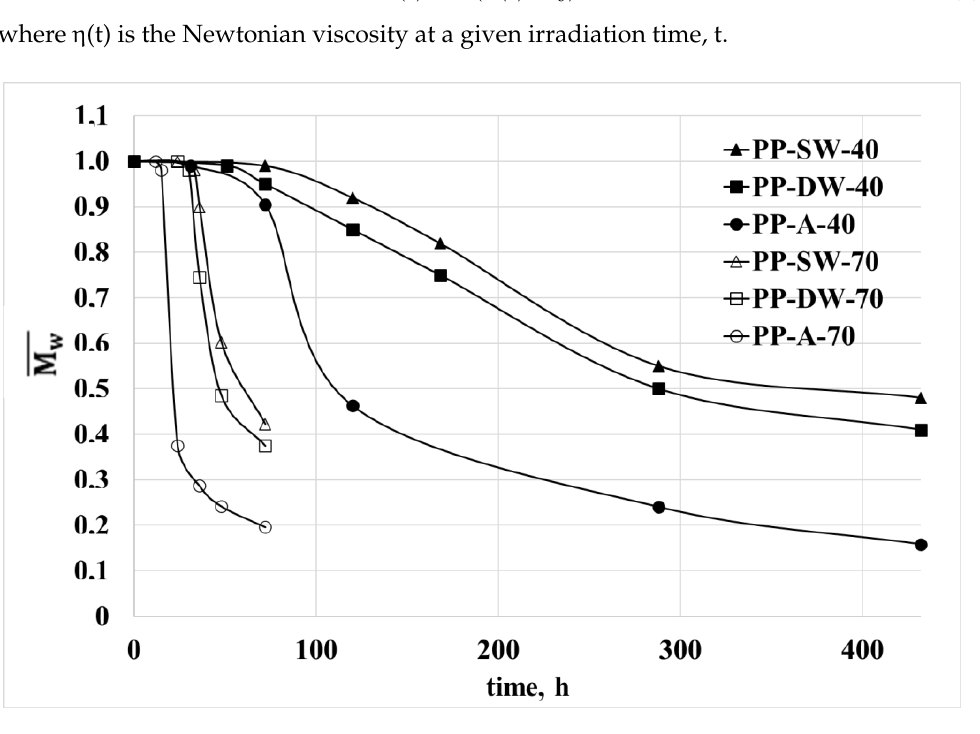
Figure 4. Concentration of oxygen as a function of the temperature for distilled and sea water.